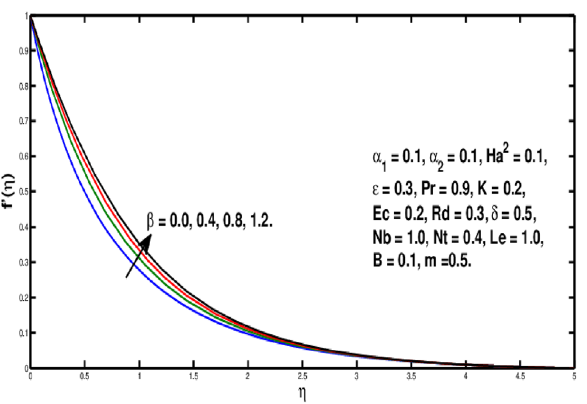
Figure 4. Variation of β on f ′ (η)